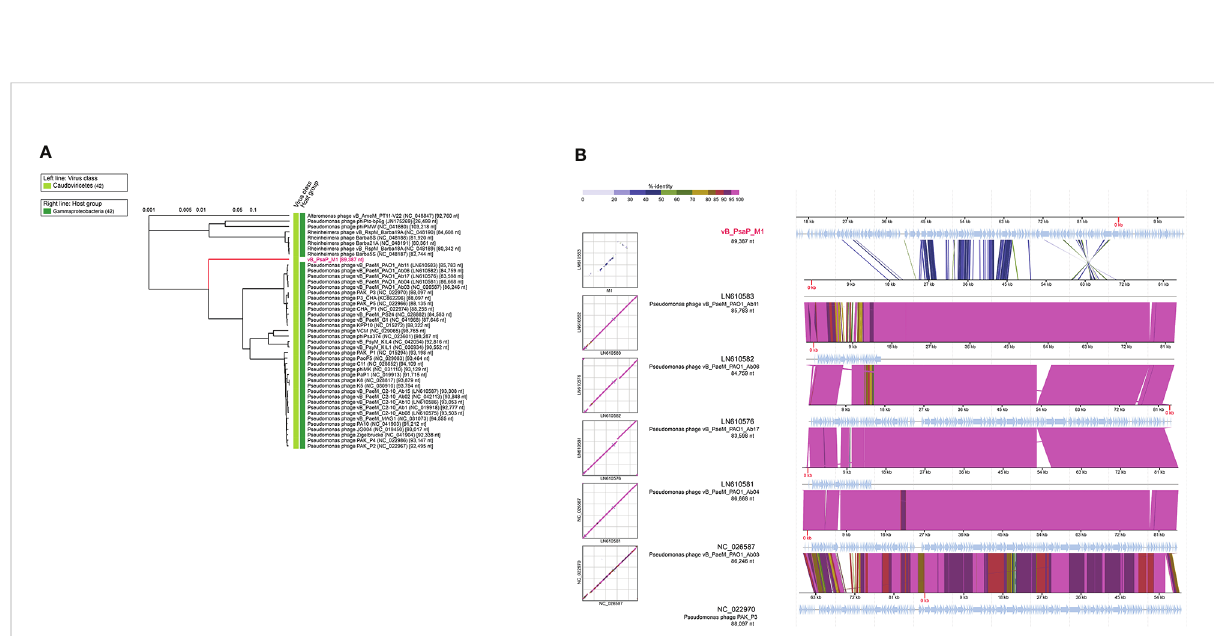
FIGURE 4 Phylogenetic and comparative genomic analyses of Pseudomonas phage vB_PsaP_M1. (A) Phylogenetic tree of Pseudomonas phage vB_PsaP_M1 and the 36 closest virus genomes. (B) Genomic comparisons between Pseudomonas phage vB_PsaP_M1 and vB_PsaP_M1-like viruses. The shading below each genome indicates sequence similarities between the genomes, with different colors representing the levels of